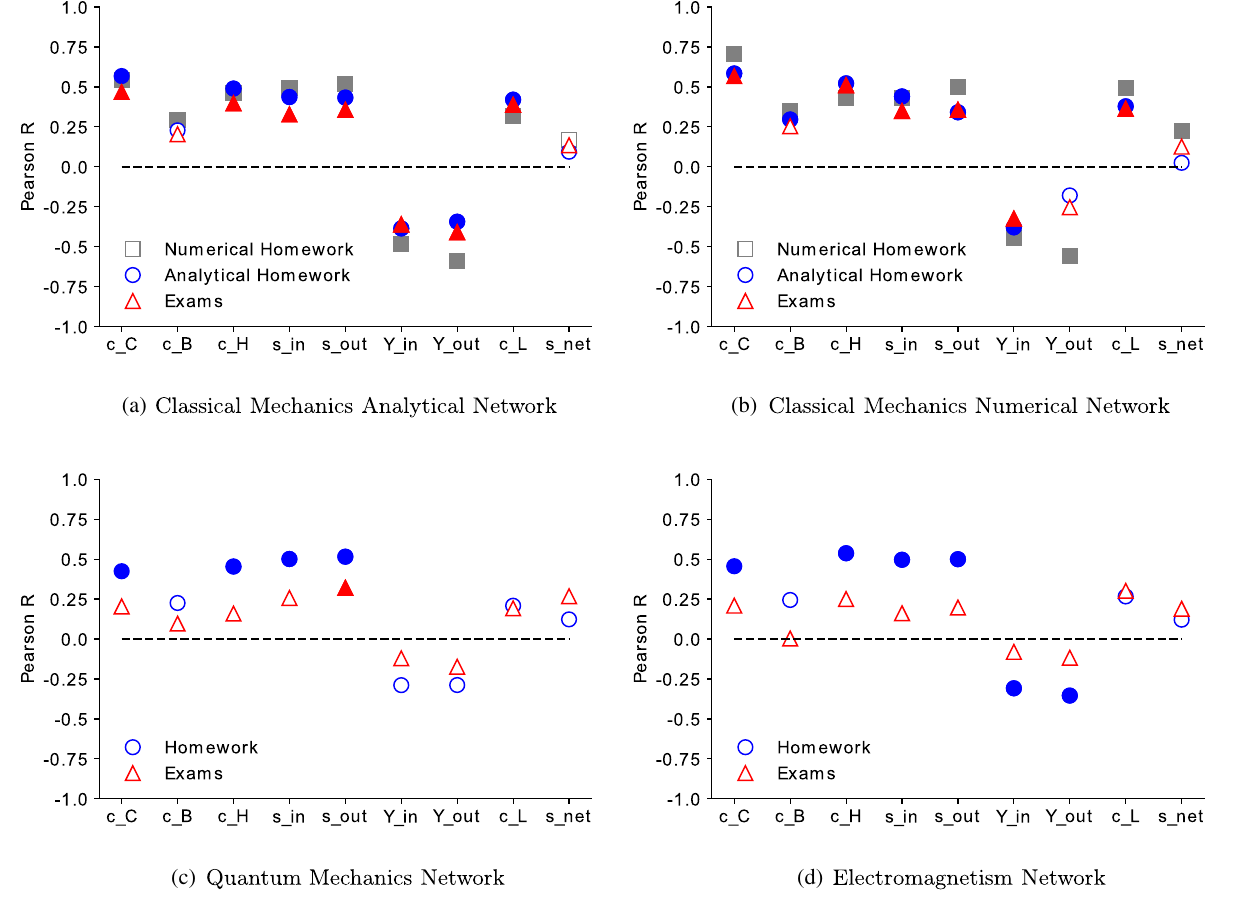
FIG. 3. Correlation of nodal centrality measures with student grades in three upper level physics courses. Correlation of complex network measures with student grades for three courses: classical mechanics, quantum mechanics, and electromagnetism. Filled markers indicate correlation coefficients that are statistically significantly different from a correlation coefficient of 0 (Holm-Bonferroni corrected p < 0 . 05 ). Statistical significance was determined using a bootstrap resampling with 10 000 resamplings of each correlation